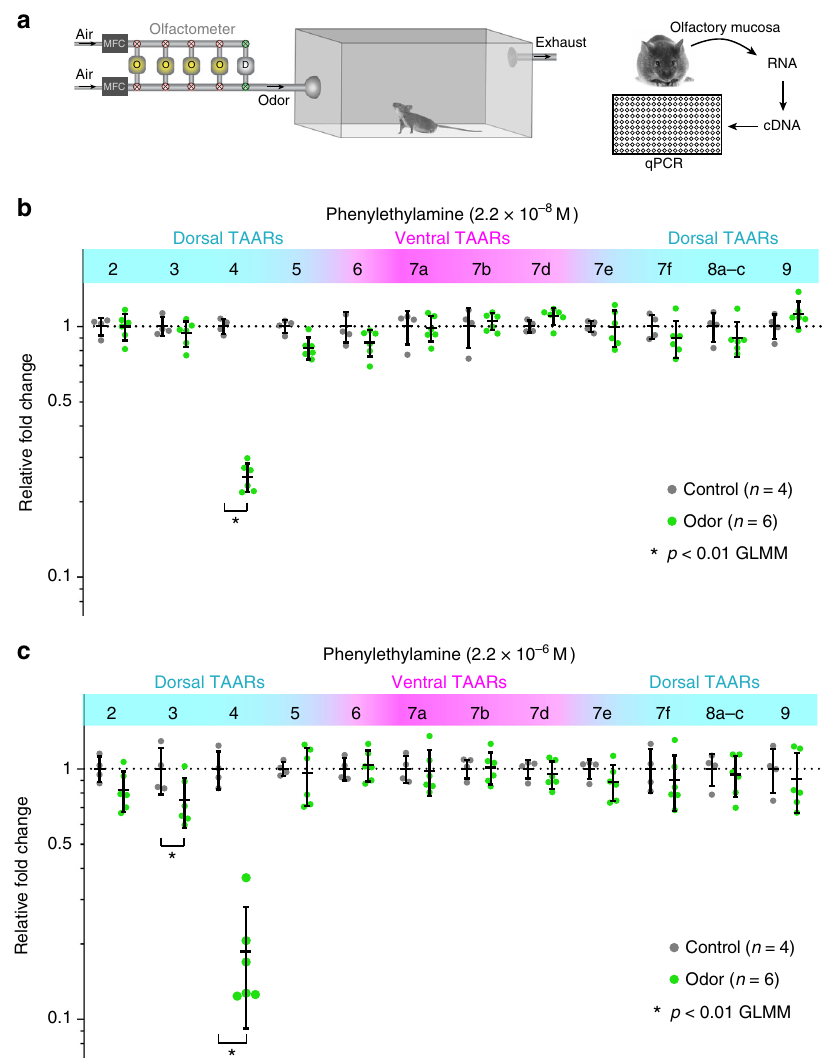
Fig. 4 Identi fi cation of TAARs that respond to phenylethylamine using DREAM. a Diagram of experimental work fl ow including odor exposure, isolation of olfactory mucosa, generation of cDNA, and measurement of receptor expression via qPCR. b , c Plots show relative levels of TAAR gene expression in the olfactory mucosa from odorized (green) and non-odorized (control; black) mice as determined by qPCR (normalized to the average non-odorized value). Mice were exposed to phenylethylamine at two concentrations for 24 h. Concentrations given are calculated values at the olfactometer outlet at the start of the experiment. Responsive TAARs are indicated by decreases in expression. Black lines displaying mean + / − SD are plotted over individual data points. Ventrally expressed TAAR genes (correspond to glomeruli outside the imaged area of the dorsal bulb) are shaded in pink. Asterisk denotes p < 0.01 General Linear Mixed